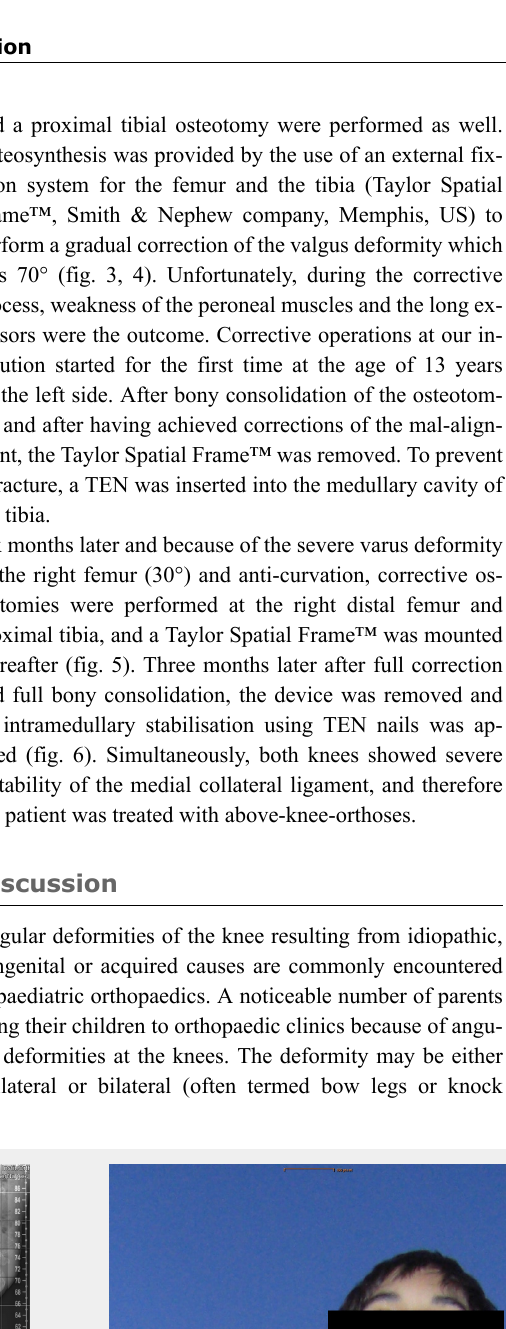
Dysmorphic facial features, bilateral congenital cataract, blepharophimosis with stiff facial muscles and an expressionless dull face are notable. Trismus is also present (spasm around the mouth making it difficult to open on command), and the mouth is involuntary held in a fixed half-smile. (The patient's father has given written informed consent for publication.)